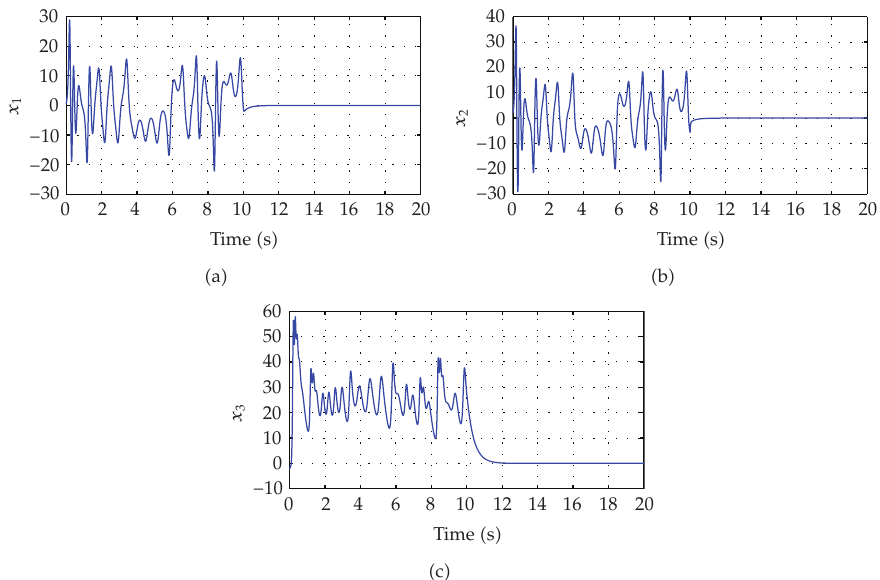
Figure 2: The time responses of controlled uncertain unified chaotic system when α 0 (cid:8) 0 . 5 and p 1 (cid:8) 0 . 49 × sin (cid:2) t (cid:3) . The control is activated at time t (cid:8) 10.